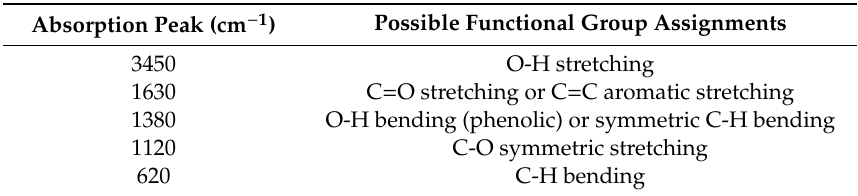
Table 2. FTIR spectra of CPH-BC-400 / 800 products and their corresponding assignments for the primary absorption peaks (cf. Figure 7).